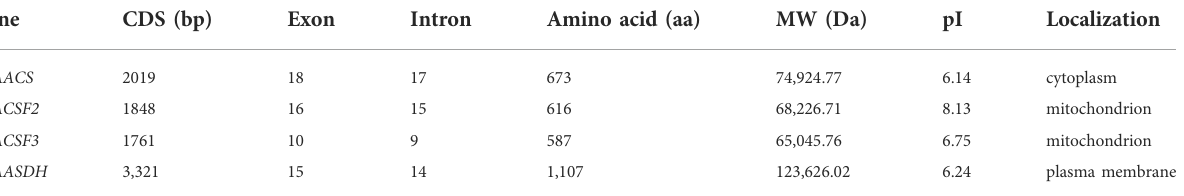
TABLE 2 Information of the other ACS